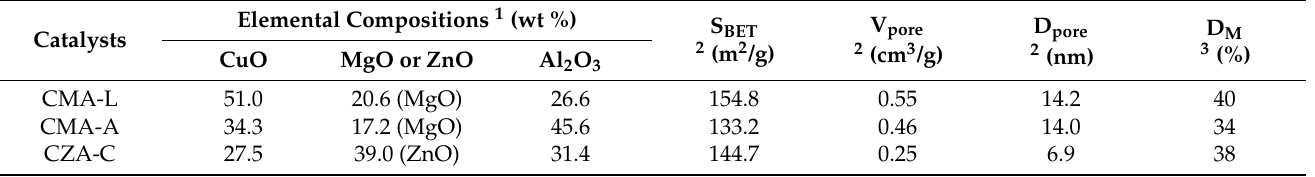
Table 1. Physicochemical properties of the calcined samples of CMA-L, CMA-A, and CZA-C.